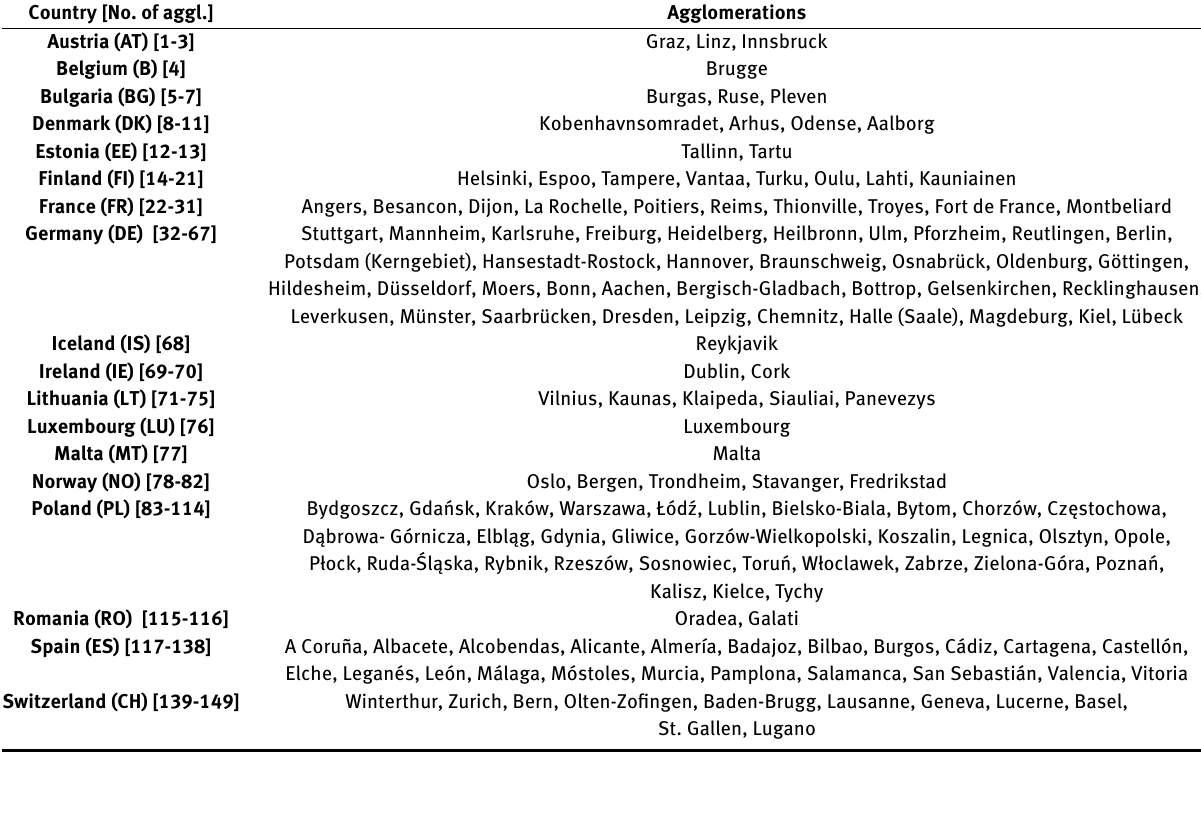
Table 2: European agglomerations. Phase II. Country [No. of aggl.]